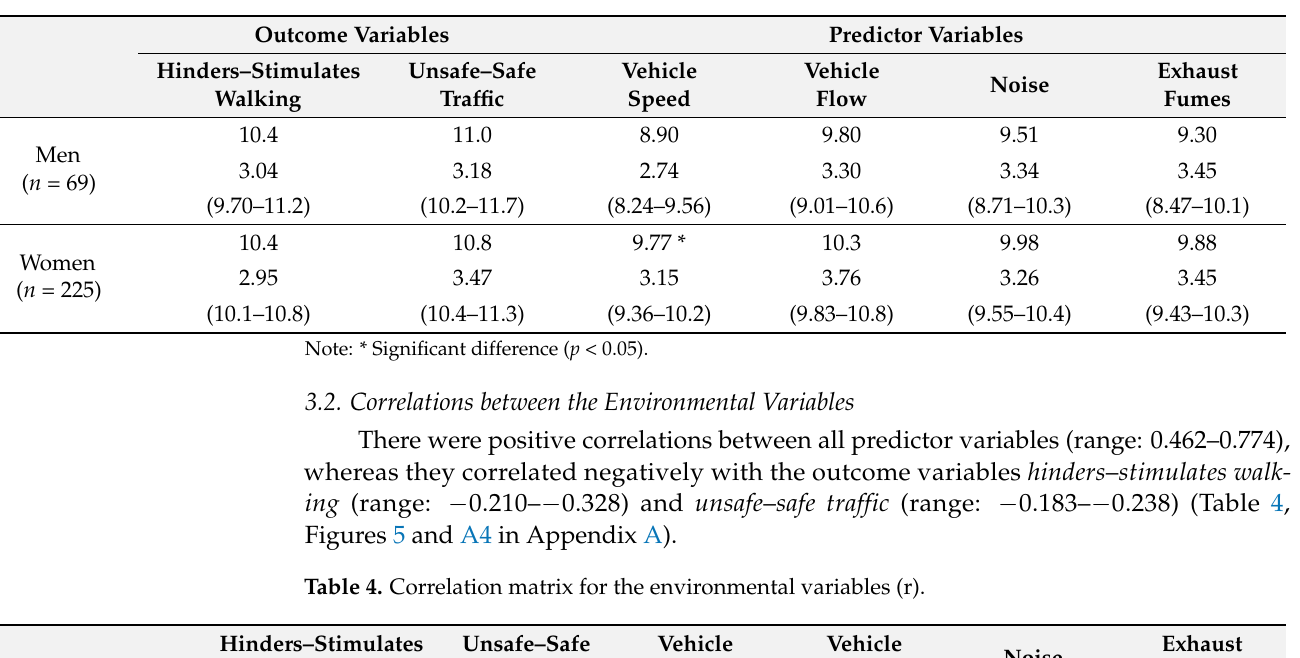
Table 3. Perceptions of the environmental variables in males and females (mean, SD, and (95% CI)). For explanation of ratings of the scale, see Table 2.